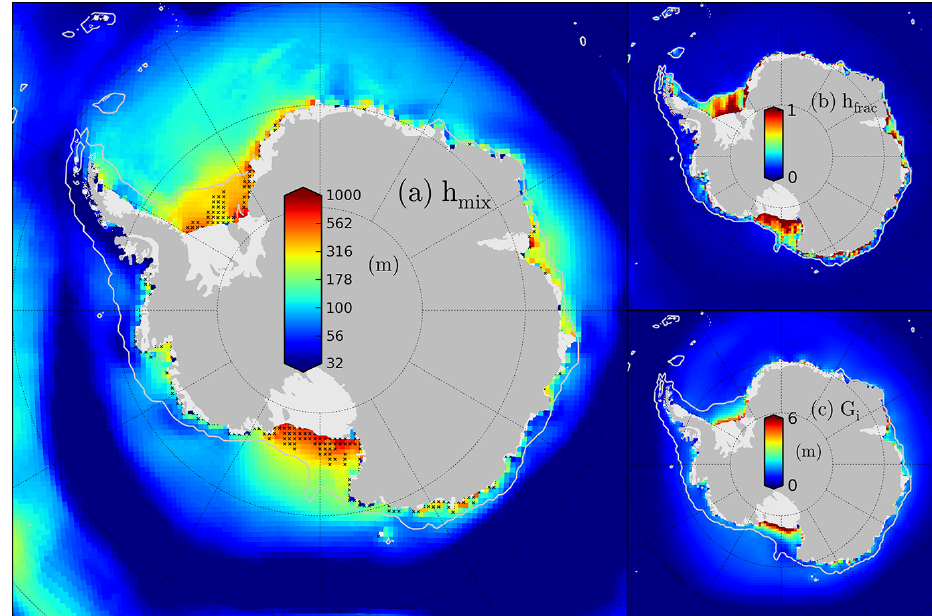
Fig. 8. Mean (1985–2011) (a) maximum mixed-layer depth, (b) fractional depth of (a) as a function of the water column depth and (c) annual ice growth. Note that a logarithmic (base 10) colour bar/scale is used in panel (a) . The black crosses highlight grid cells where the maximum mixed-layer depth is greater than 90% of the water column depth. The white line is the 1000m isobath contour taken from the RTOPO data set (Timmermann et al.,